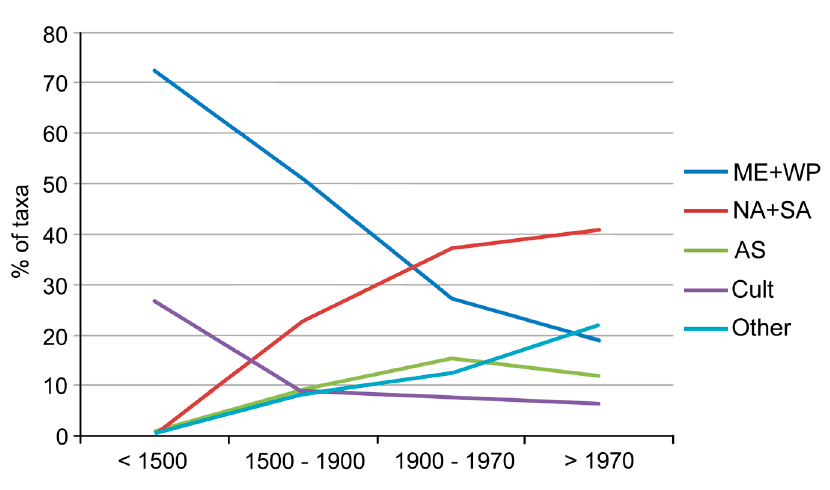
Figure 6. Temporal changes in the proportional contribution of the introduced plants, according to their origin, in